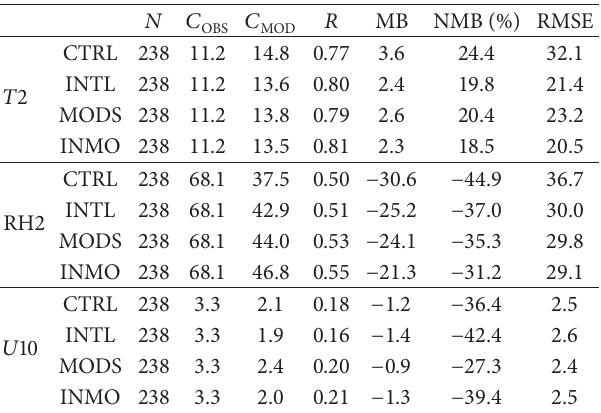
Table 5: Statistics of 2 m temperature 𝑇 2, RH2, and 𝑈 10 between the observation and model results at Arou station.